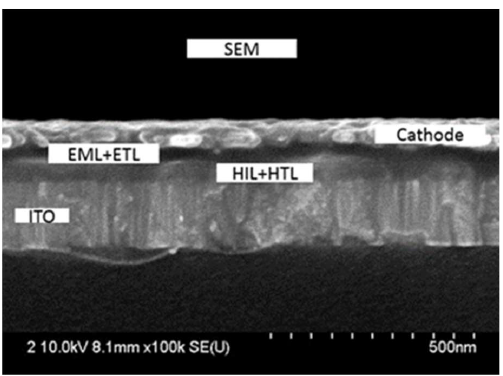
Figure 2. Scanning electron microscope (SEM) images of the TPA-1A-based device cross-section.